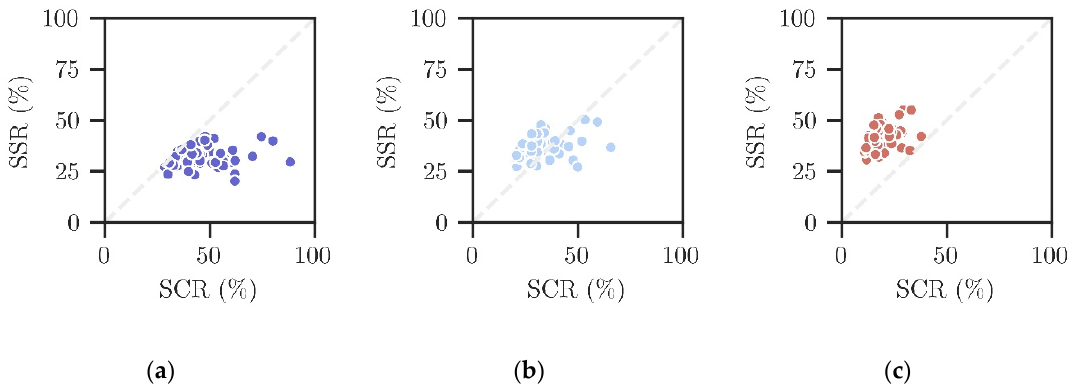
Figure 8. Effects of different PV capacities on households’ energy performance; ( a ) 3 kWp; ( b ) 5 kWp*; ( c ) 10 kWp* (n = 55); (* upscaled from 3 kWp PV generation profiles).